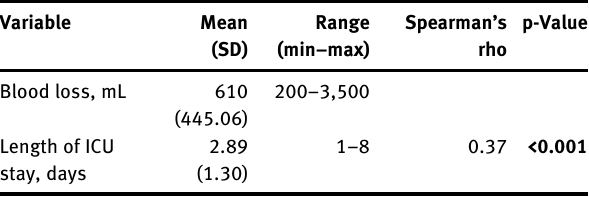
The bold values in table highlight that the p-values are statistically